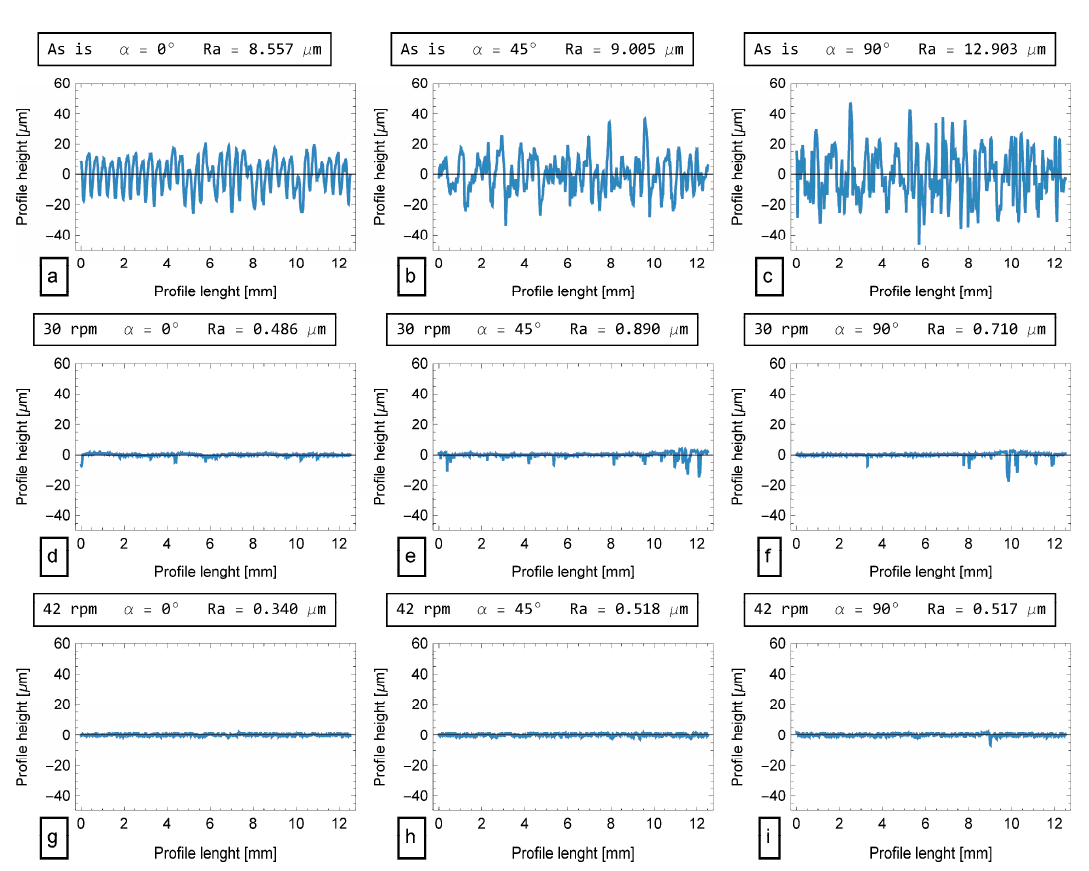
Figure 7. Roughness profiles for investigated specimen orientations before BF conditioning ( a,b,c ) after BF at 30 rpm ( d,e,f ) and after 42 rpm ( g,h,i ).